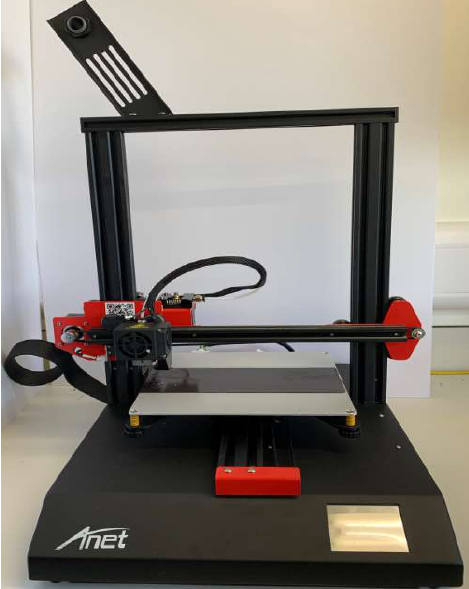
Figure 1. Anet ET4 Pro 3D printer.